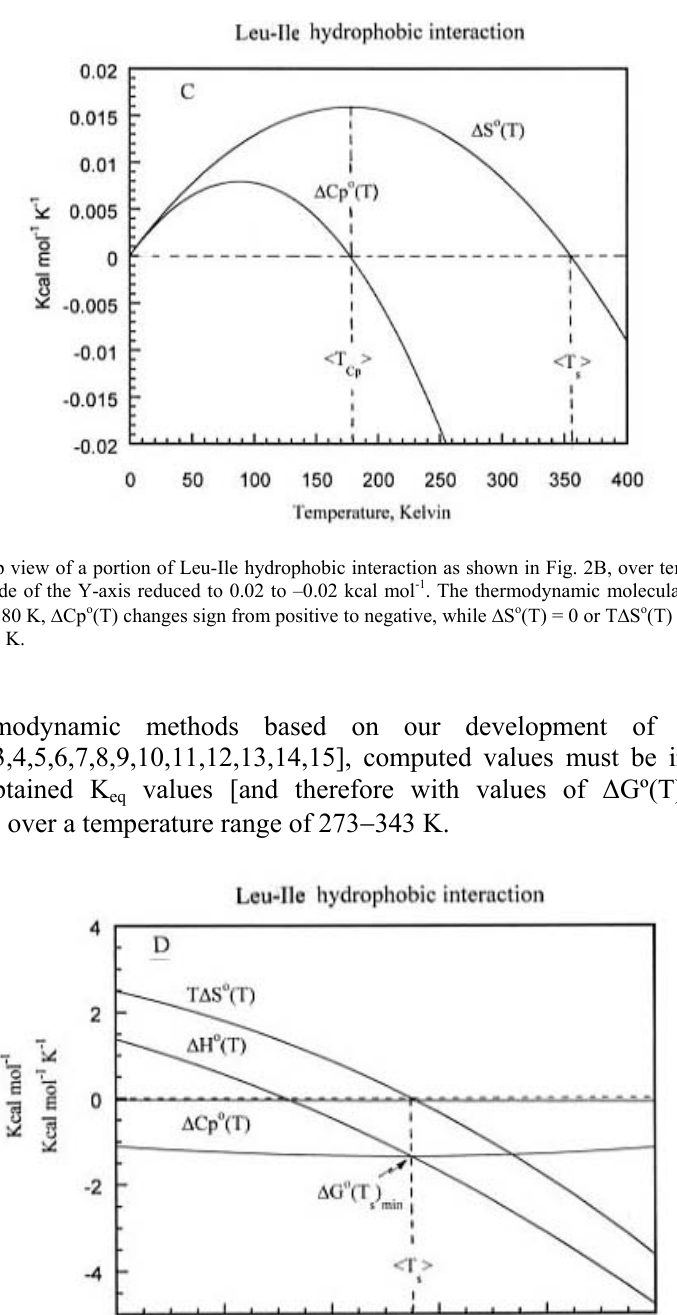
FIGURE 2D . A close-up view of a portion of Leu-Ile hydrophobic interaction as shown in Fig. 2B, over the temperature range of 300–400 K, with the magnitude of the y-axis reduced to 4 to –4 kcal mol -1 K -1 .